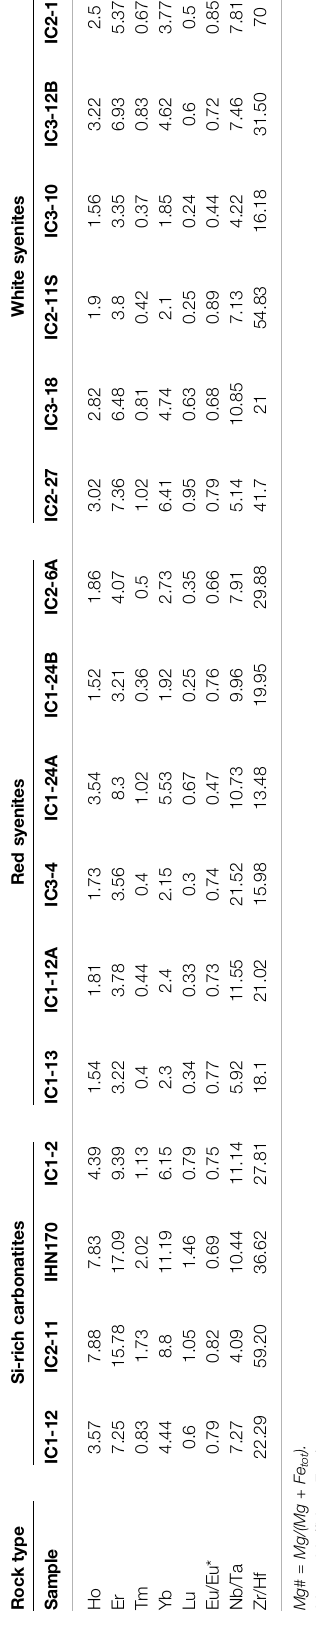
All clinopyroxenes in carbonatites are euhedral diopside (En 26 – 33 Fs 17 – 23 Wo 45 – 51 ) or hedenbergite (En 18 – 22 Fs 30 – 32 Wo 46 – 48 ) phenocrysts ( Figure 7A ; Supplementary Table S3 ), and no dissolution/recrystallization texture or core to rim zonation has been observed. In Si-poor carbonatites, clinopyroxenes are diopsides (En 28 – 33 Fs 17 – 22 Wo 48 – 51 ) with relatively high Mg# (Mg# (cid:1) Mg/[Mg T A